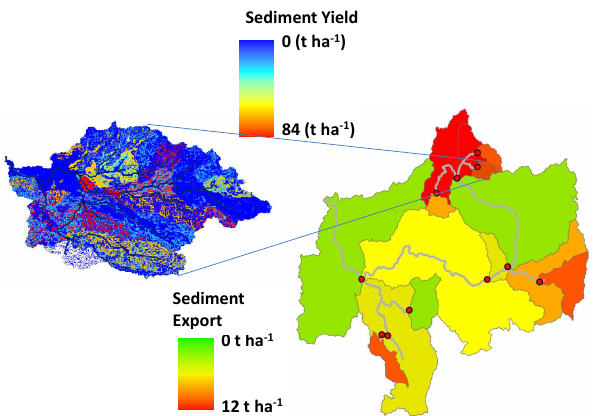
Fig. 12. Sediment export (t ha − 1 yr − 1 ) in the subbasins predicted by the model (main figure) and sediment yield by hydrologic re- sponse unit (HRU) for the Gumera subbasins